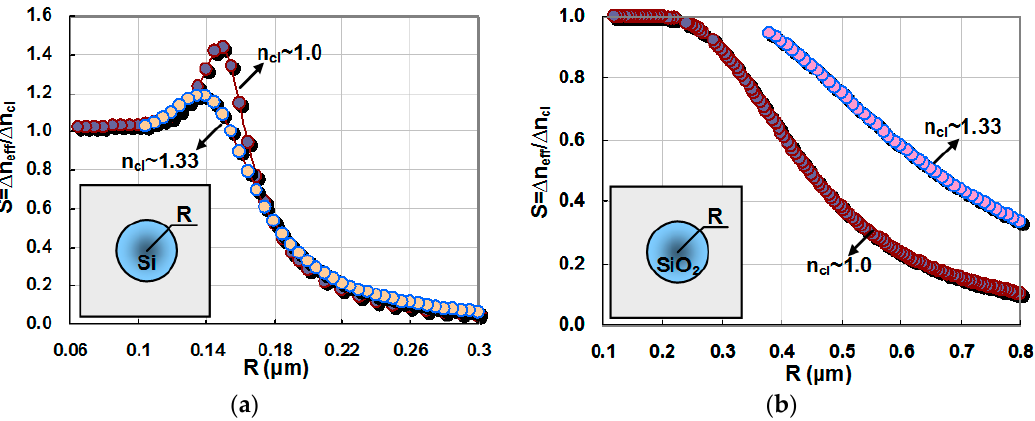
Figure 4. The sensitivity for a nanofiber with: ( a ) Si core; and ( b ) SiO 2 core.